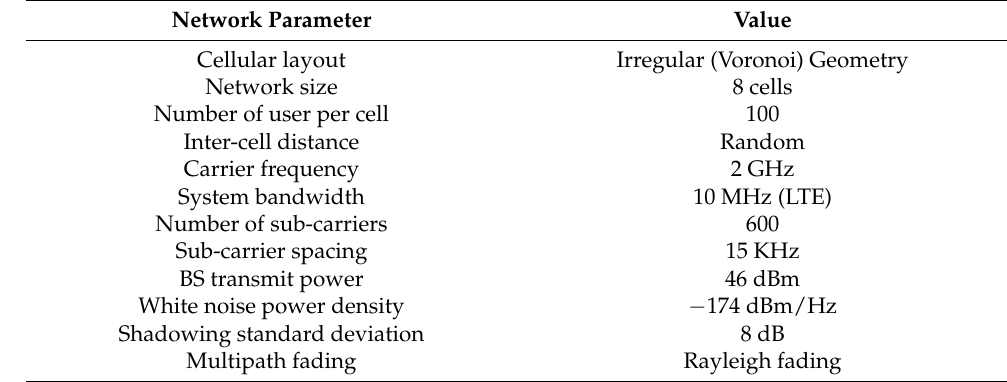
Table 1. Simulation